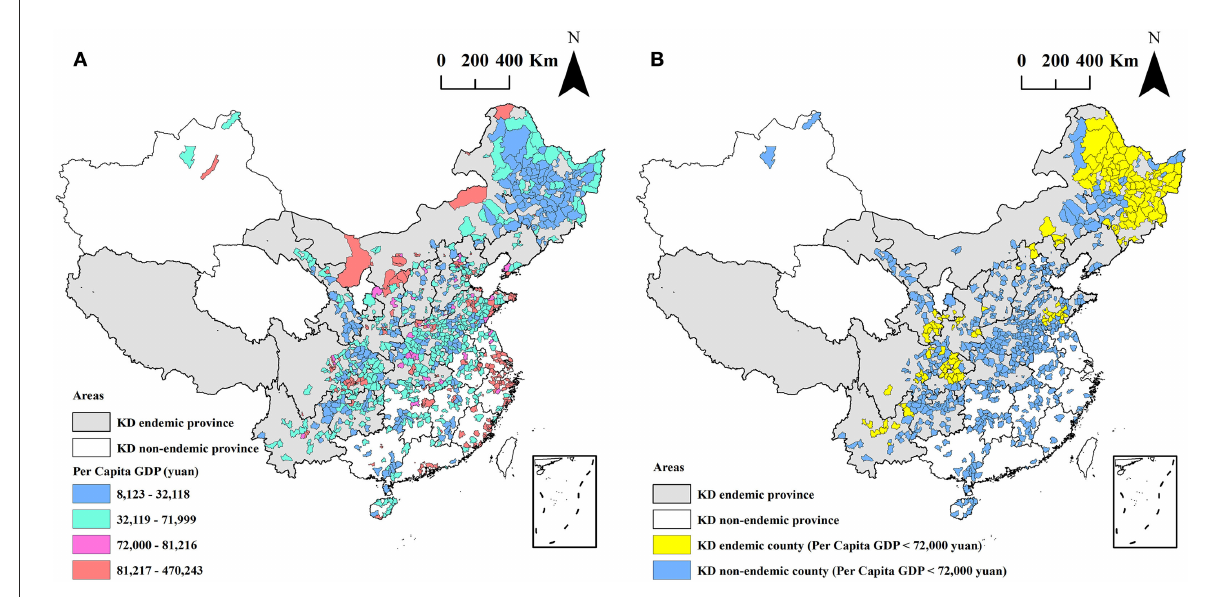
FIGURE4 The spatial distribution of per capita GDP at the county level (A) and the counties with a per capita GDP lower than RMB 72,000 (B) .